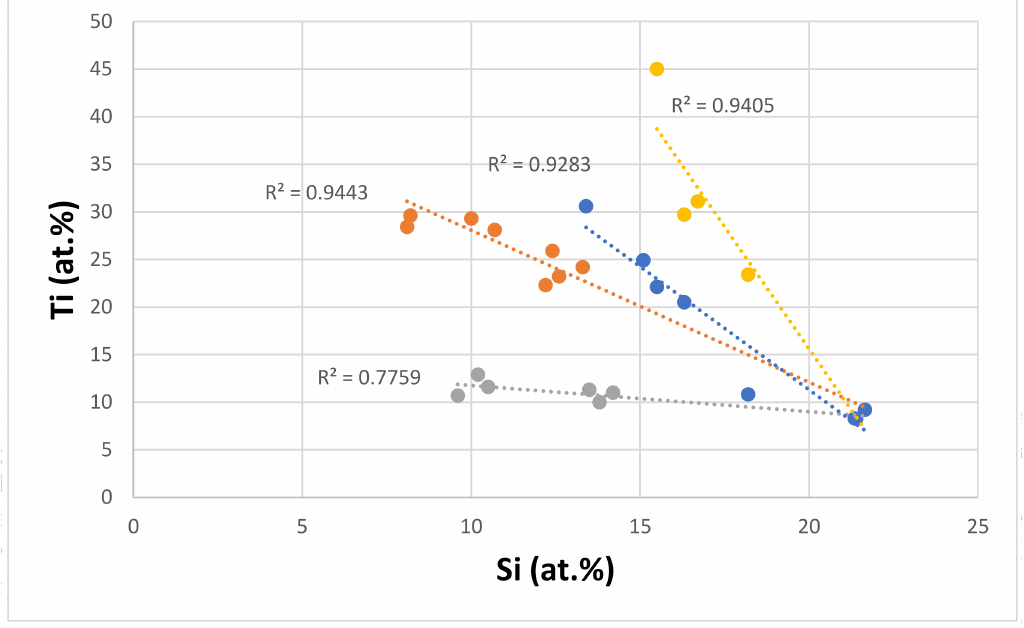
Figure 9. Ti versus Si of eutectics with Nb ss and Nb 5 Si 3 in Nb-silicide based alloys, series a (R 2 = 0.9443), with alloying element additions of Al, Cr, Ge, Hf, Mo, Si, Sn, Ti, W, and Y; series b (R 2 = 0.7759) with alloying element additions of Al, Cr, Ge, Hf, Mo, Si, Sn, Ti, V, and W; series c (R 2 = 0.9405) with alloying element additions of Al, Cr, Fe, Hf, Mo, Si, Sn, Ti, V, and W; series d (R 2 = 0.9283) with alloying element additions of Ge, Hf, Mo, Si, Sn, Ta, Ti, and